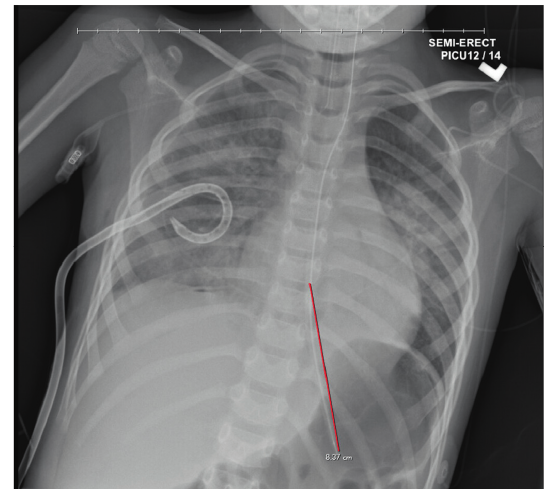
Figure 2: An endotracheal tube with the tip projecting over the mid-thoracic trachea; well-inflated lungs with multifocal patchy opacities likely compatible with multifocal infection, hemorrhage, ARDS, and/or pulmonary edema; small right hydropneumothorax with the chest tube in